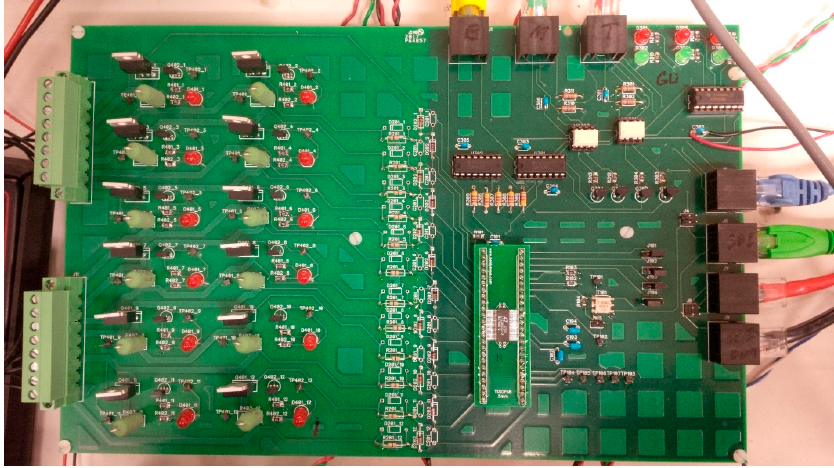
Figure 6. PEQ control board including LTC6804 controller and 12 PEQ cell discharge resistors.